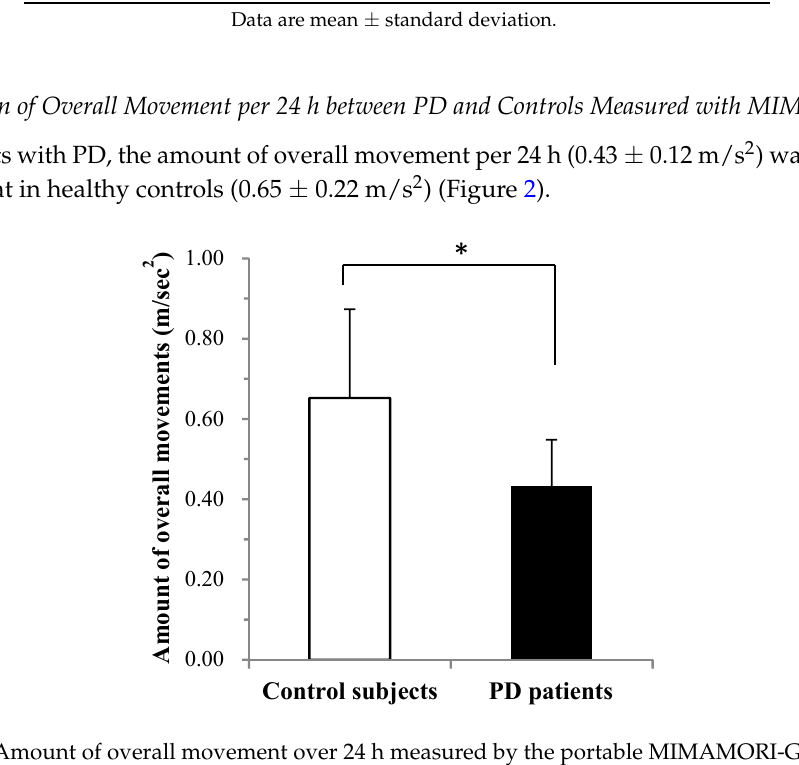
Figure 2. Amount of overall movement over 24 h measured by the portable MIMAMORI-Gait device in patients with Parkinson’s disease (PD) and healthy control subjects. Data are mean ± SD. * p < 0.01.